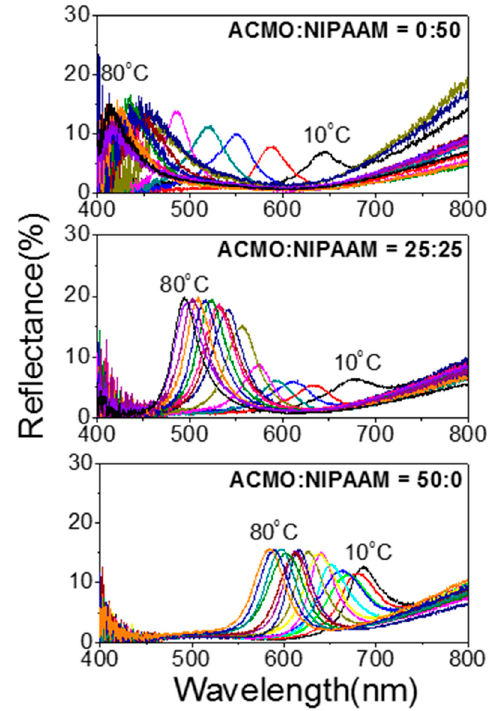
Figure 5. Temperature-dependent changes of the reflectance spectra of three IO photonic gels containing different molar ratios of NIPAAM and ACMO.